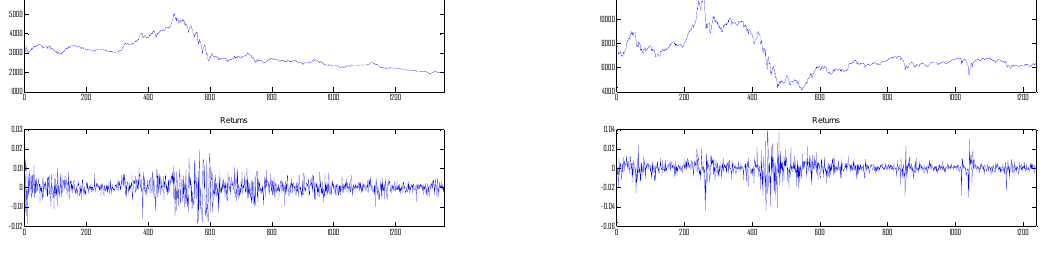
Fig. 1.a Series of Jordanian stock market price level and returns